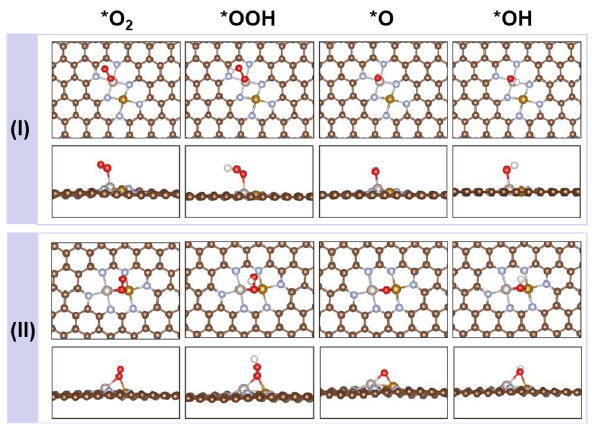
Figure 3. Typical structures for the key oxygen containing intermediates for both FeMN 6 (I) (top) and FeMN 6 (II) (bottom), top view and side view.